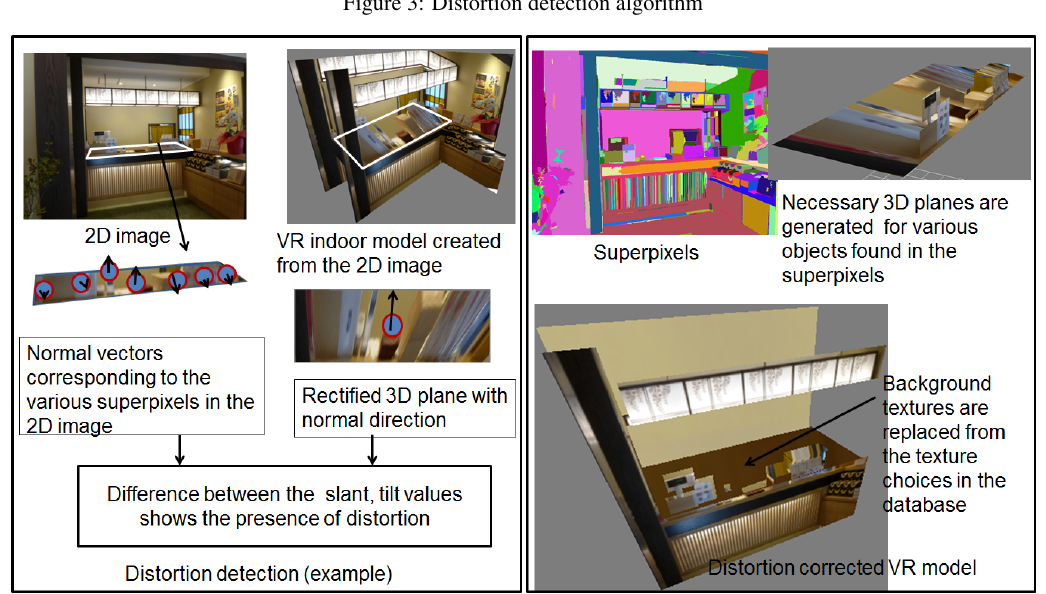
Figure 3: Distortion detection algorithm